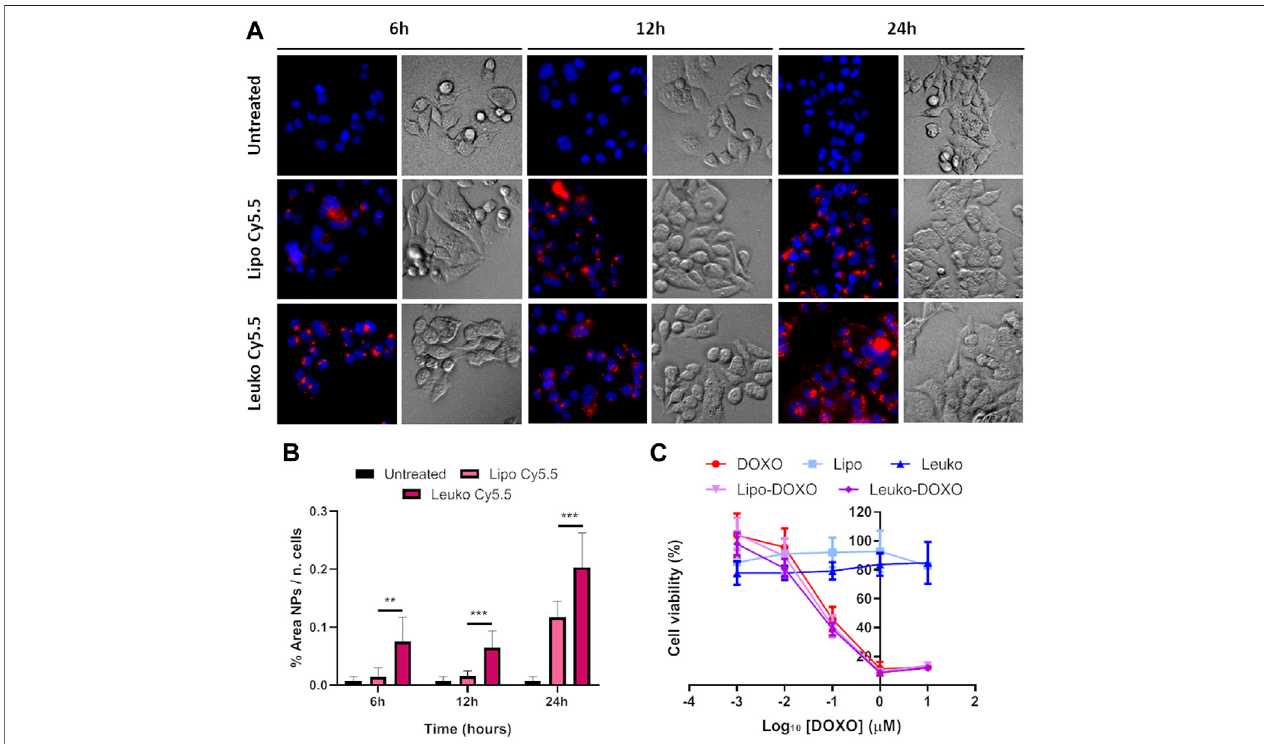
FIGURE 8| (A) Fluorescence (Fluo) and respective bright fi eld (BF) imagesof HCT-116 cells cultured onto fl at plates treated with either Lipo Cy5.5 or Leuko Cy5.5 for 6, 12, and 24 h. (B) Quanti fi cation of Lipo and Leuko fl uorescence at different time points during uptake. (C) Resazurin cell viability assay results for DOXO, Lipo, Leuko, Lipo-DOXO, and Leuko-DOXO on HCT-116 cells. ( pp p ˂ 0.01; ppp p ˂ 0.001, and n = 3 for all the performed